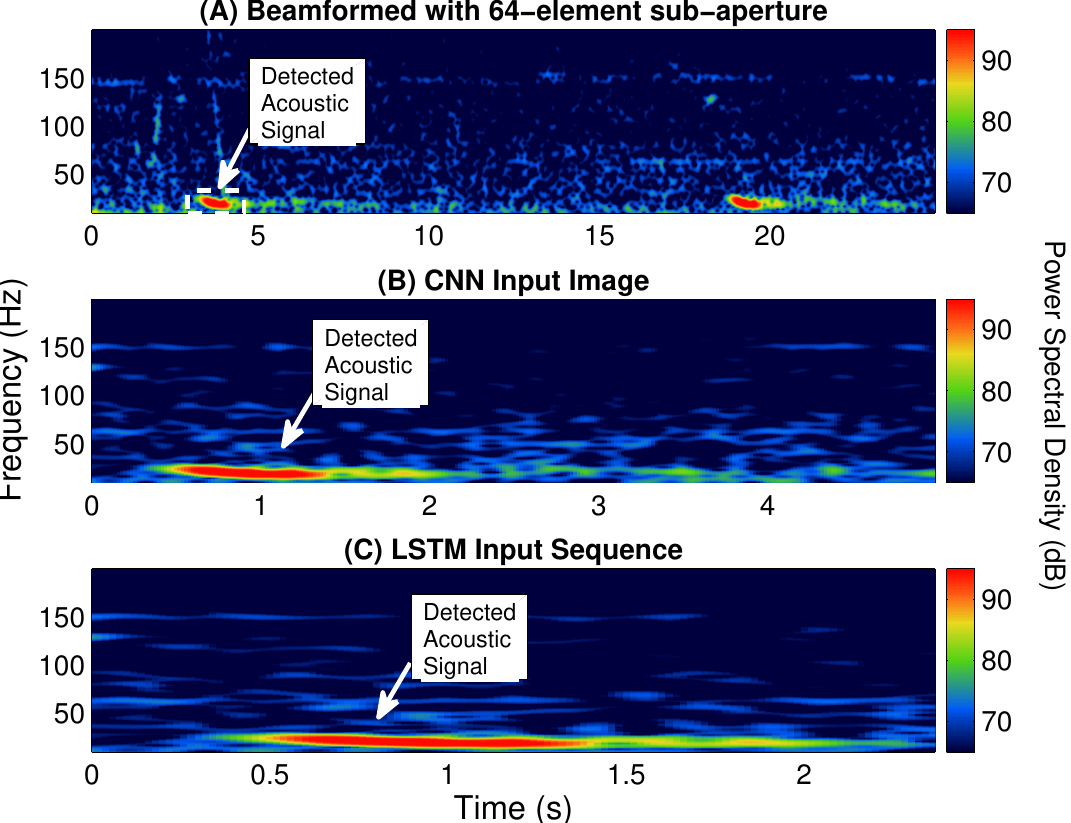
Figure 6. Plot ( A ) is an example of a beamformed spectrogram containing two fin whale 20 Hz pulses. Plot ( B ) and plot ( C ) are examples of a CNN input data image and LSTM input data sequence for the first 20 Hz pulse in plot ( A ). All the CNN images are defined to be 5 s in length due to hardware limitations, while the length of all the LSTM input data sequences are defined by the duration of each detected acoustic